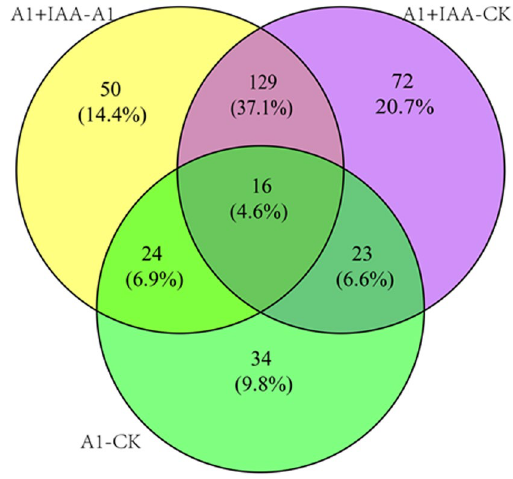
Figure 1. Venn diagram of the relationship of intersection of differentially expressed proteins responsive to Al and IAA co-treatment compared with Al alone in roots of